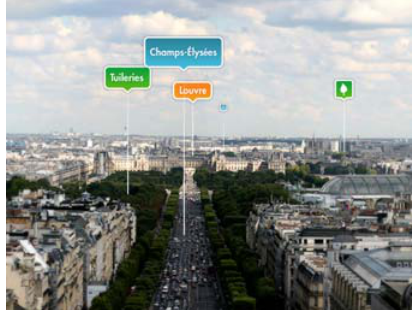
Fig. 9. View from “ Arc de Triomphe, Paris (France)” with information balloon with the name of the historical